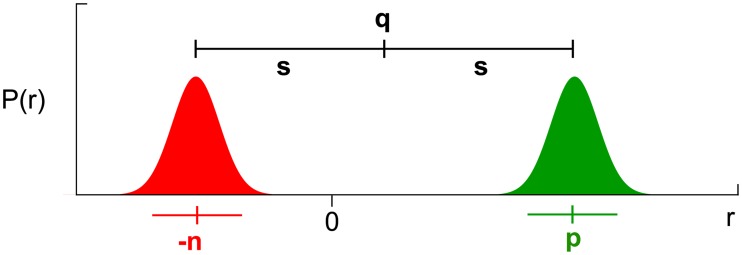
The relation of reinforcement statistics to payoff and cost.The graph shows a representative reinforcement distribution over the magnitude r of all received reinforcements. The parts of the distribution that indicate negative reinforcements (costs) are colored red, while the parts that indicate positive reinforcements (payoffs) are colored green. The mean q and the mean spread s are indicated above the distribution, the mean cost −n and the mean payoff p are indicated below the distribution.